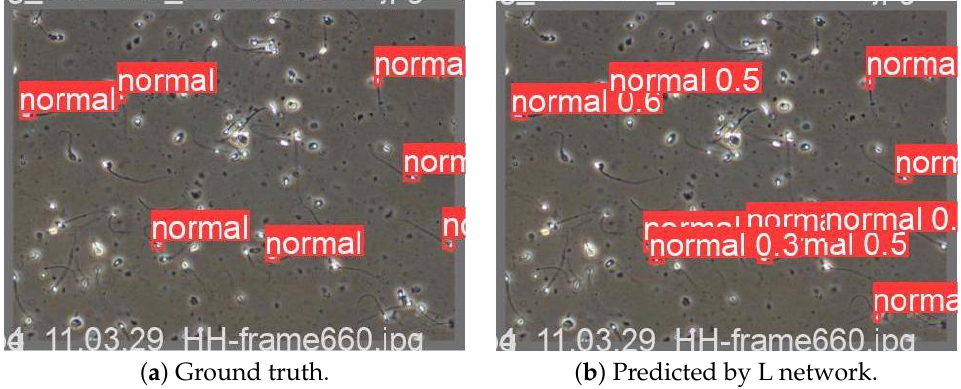
Figure 6. Comparison for validation dataset labels of ( a , b ). Generated during training-best